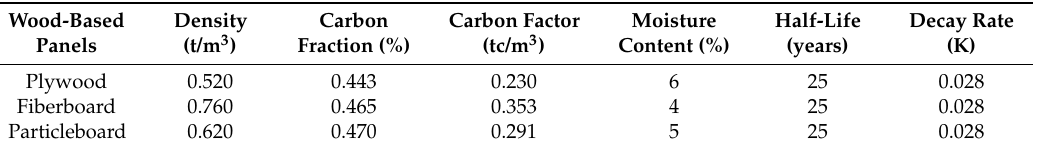
Table 3. Various carbon conversion factors of wood-based